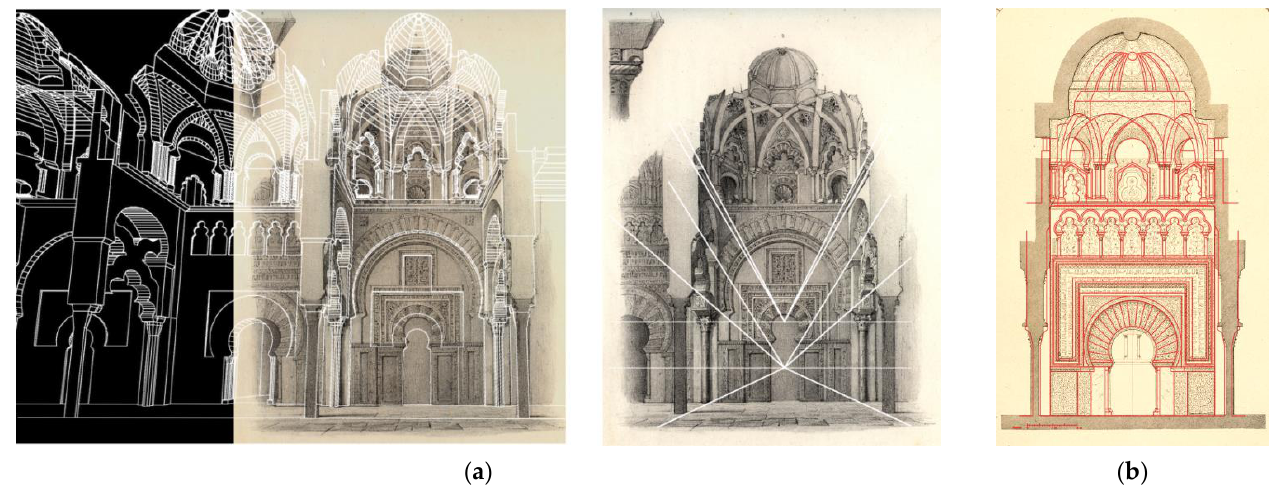
Figure 25. Girault de Prangey (1841 and 1839): ( a ) Digital model overlapping the mihrab annexed to the mihrab. Duplicity in horizon and vanishing. ( b ) Mihrab section overlapping the current section. Source: Own production.